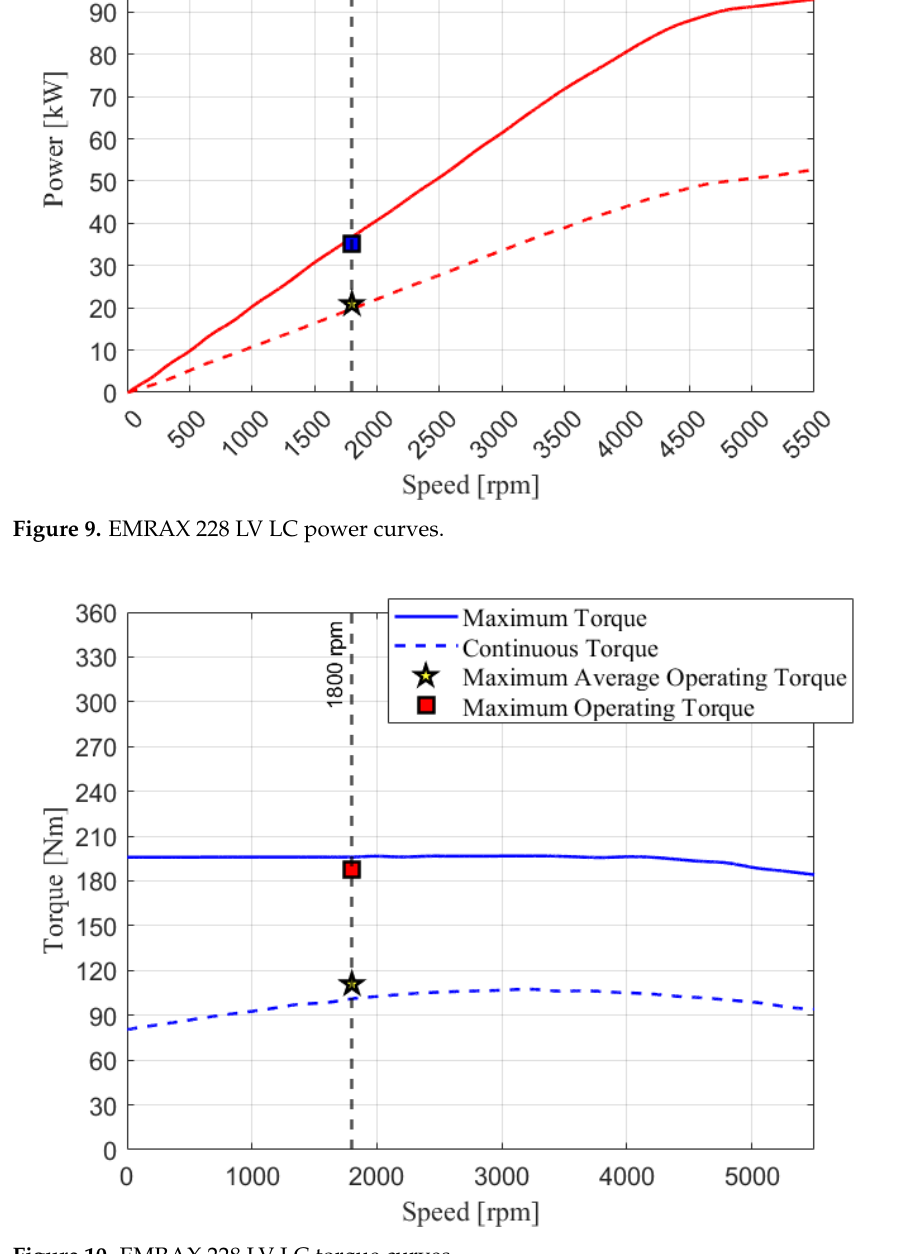
Figure 10. EMRAX 228 LV LC torque